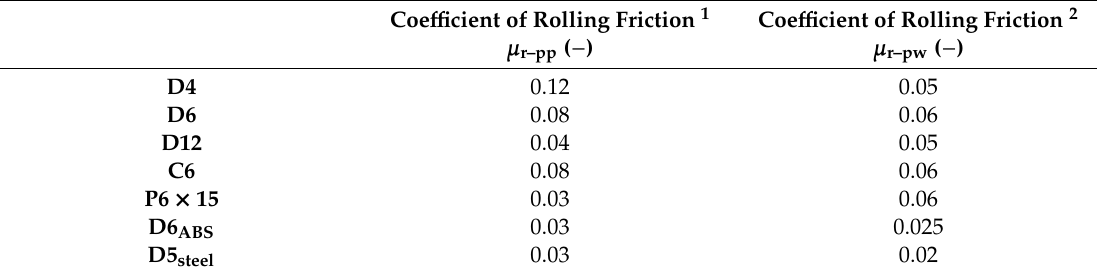
Table A7. Coe ffi cient values of contact rolling